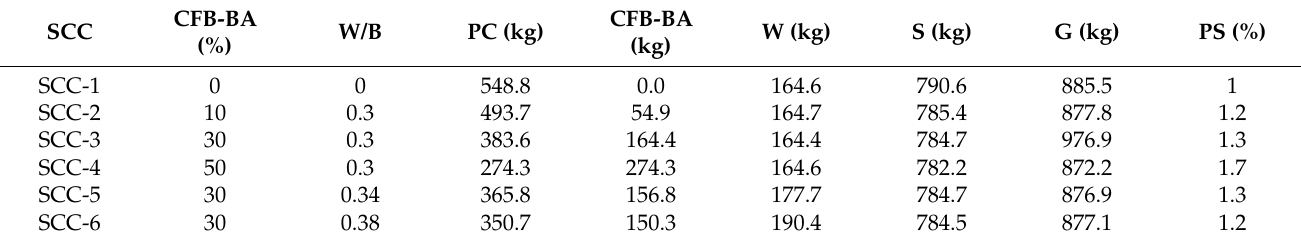
Table 5. Mix proportions of